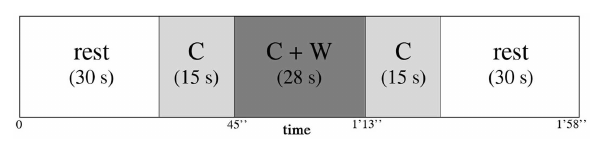
FIGURE 1 | Representation of one encoding block between two 30s rest blocks . Each block consisted of 15s of context (C) alone, either music or silence in the earphones, then 28s of context and words (C + W) encoding (seven words for each block, 4s per word), and then again 15s of context (C)